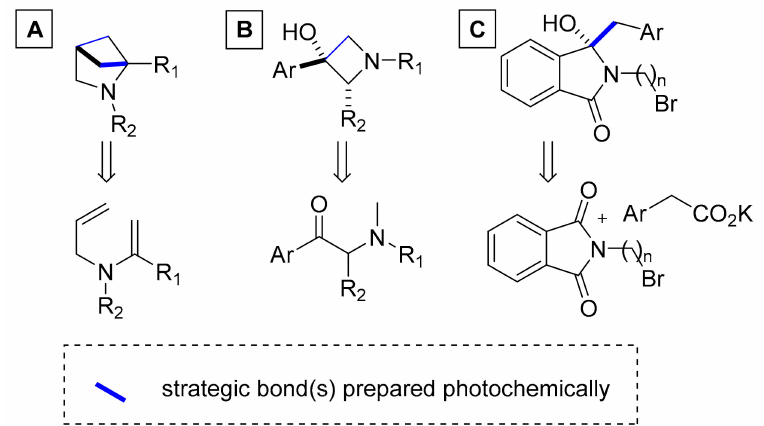
Figure 11. Structures of drug-like heterocyclic entities prepared photochemically and their precursors. ( A ) synthesis of 2,4-Methanopyrrolidines; ( B ) synthesis of 3-hydroxyazetidines; ( C ) photobenzylation of substituted